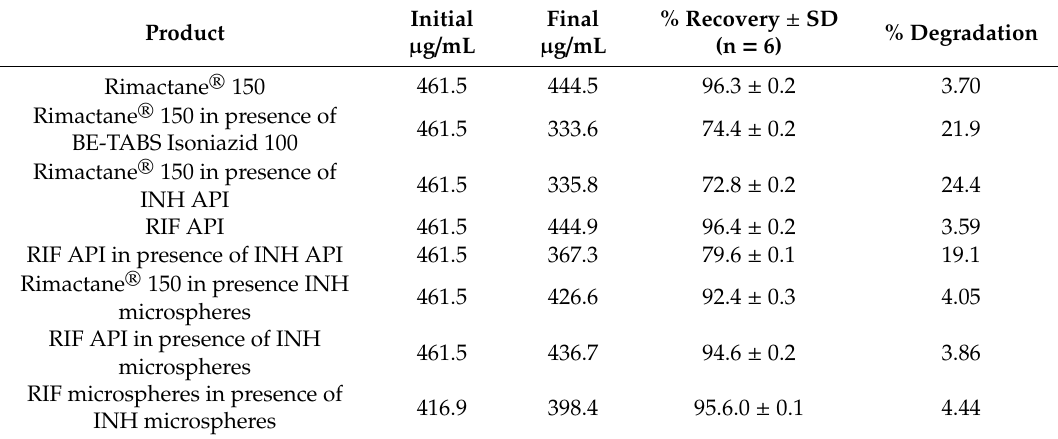
Table 14. Dissolution of RIF in the presence of INH in pH 1.2, 0.1 M